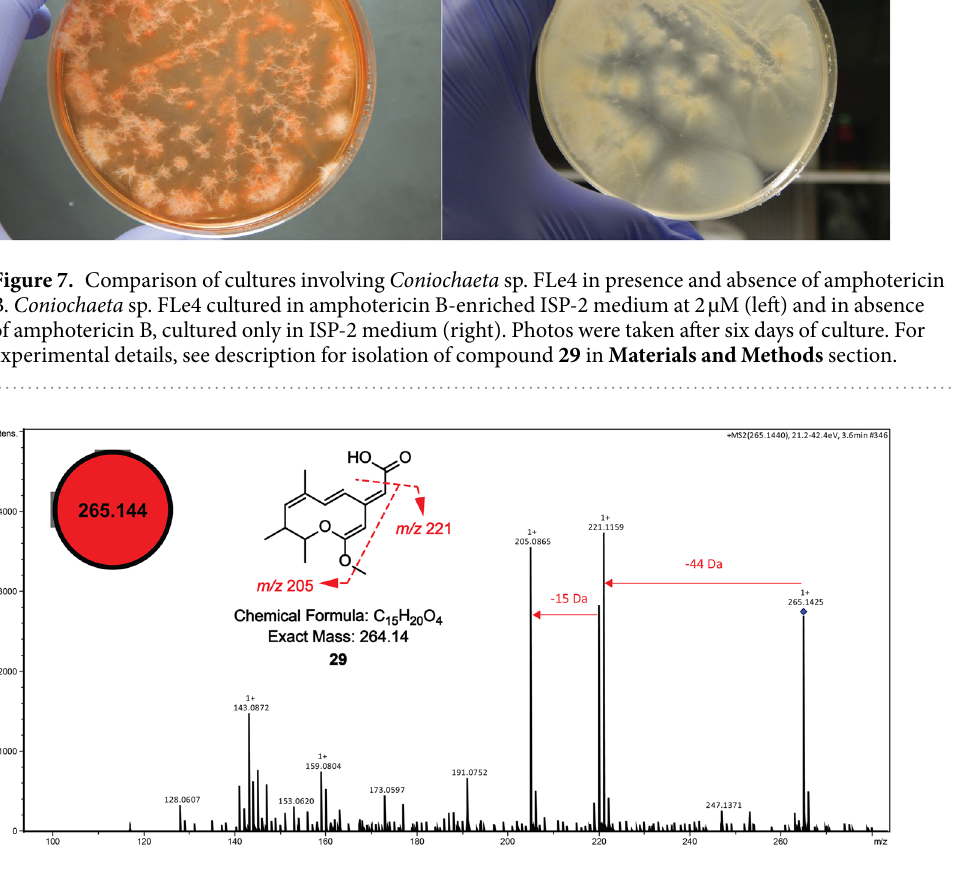
Figure 8. Node and representative MS/MS spectrum of m/z 265 (compound 29 ) from Coniochaeta sp. FLe4. Red node corresponds to detected metabolites from microbial interactions (co-cultures). Specifically, the node of m/z 265 was detected from samples of co-cultures involving Coniochaeta sp. FLe4 with S . cattleya RLe1, S . mobaraensis RLe3, S . albospinus RLe7 and K . cystarginea